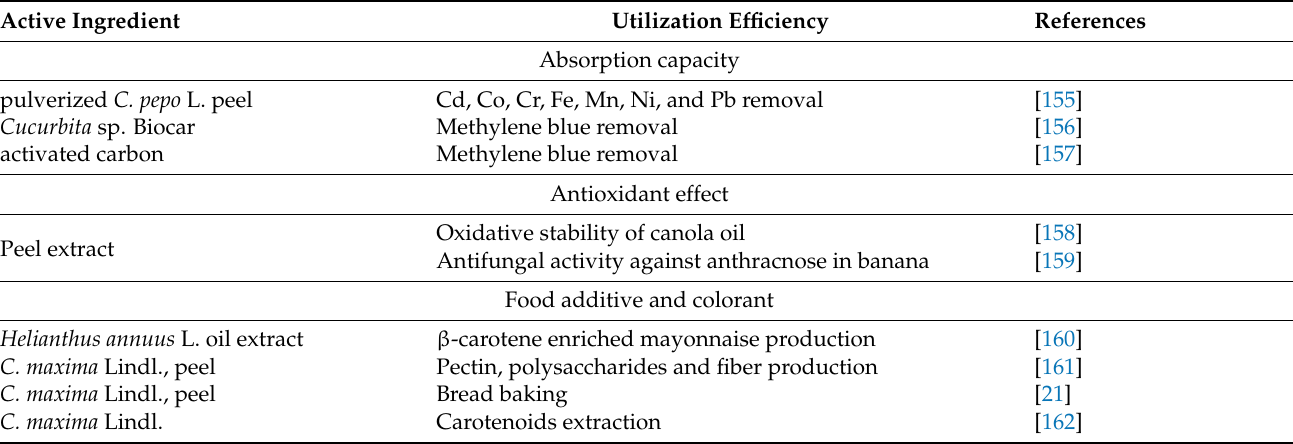
Table 7. Utilization of pumpkin exocarp.